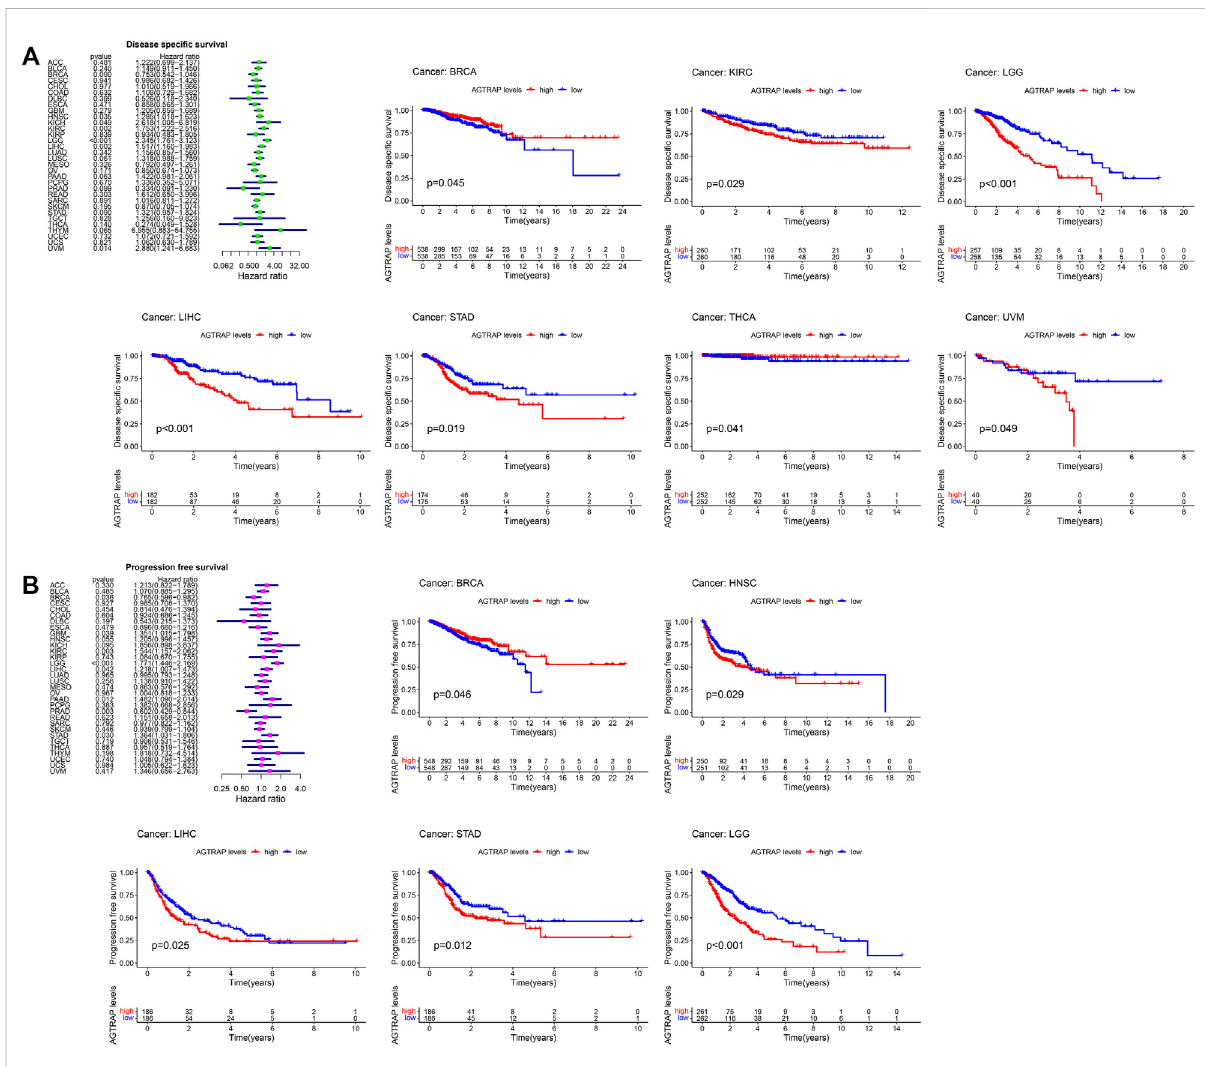
FIGURE 4 Correlation between the expression of AGTRAP and prognosis in pan-caner. (A) Relationship of disease-speci fi c survival (DSS) and AGTRAP expression in pan-cancer. (B) Relationship of progression-free survival (PFS) AGTRAP expression in pan-cancer.